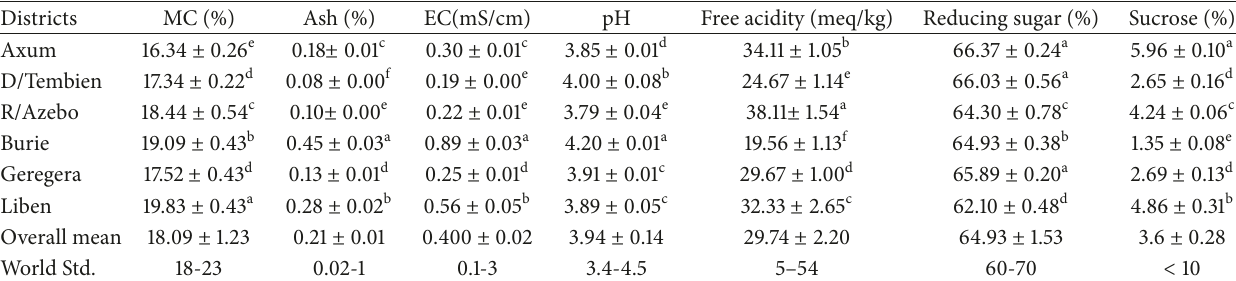
Table 1: Physicochemical composition of honey samples of the study